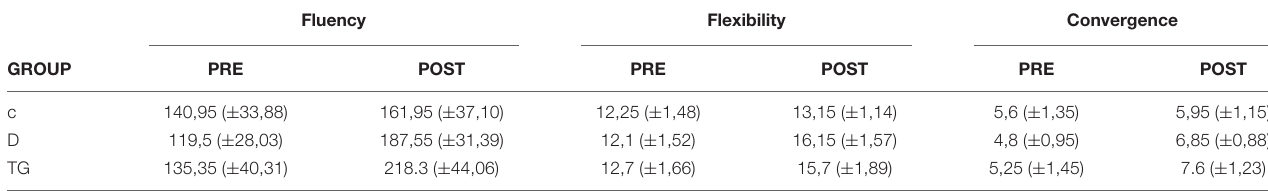
TABLE 6 | Means and standard deviations for the fluency (FLU), flexibility (FLEX), and convergence (CONV) for the PRE and POST measures in the three groups.